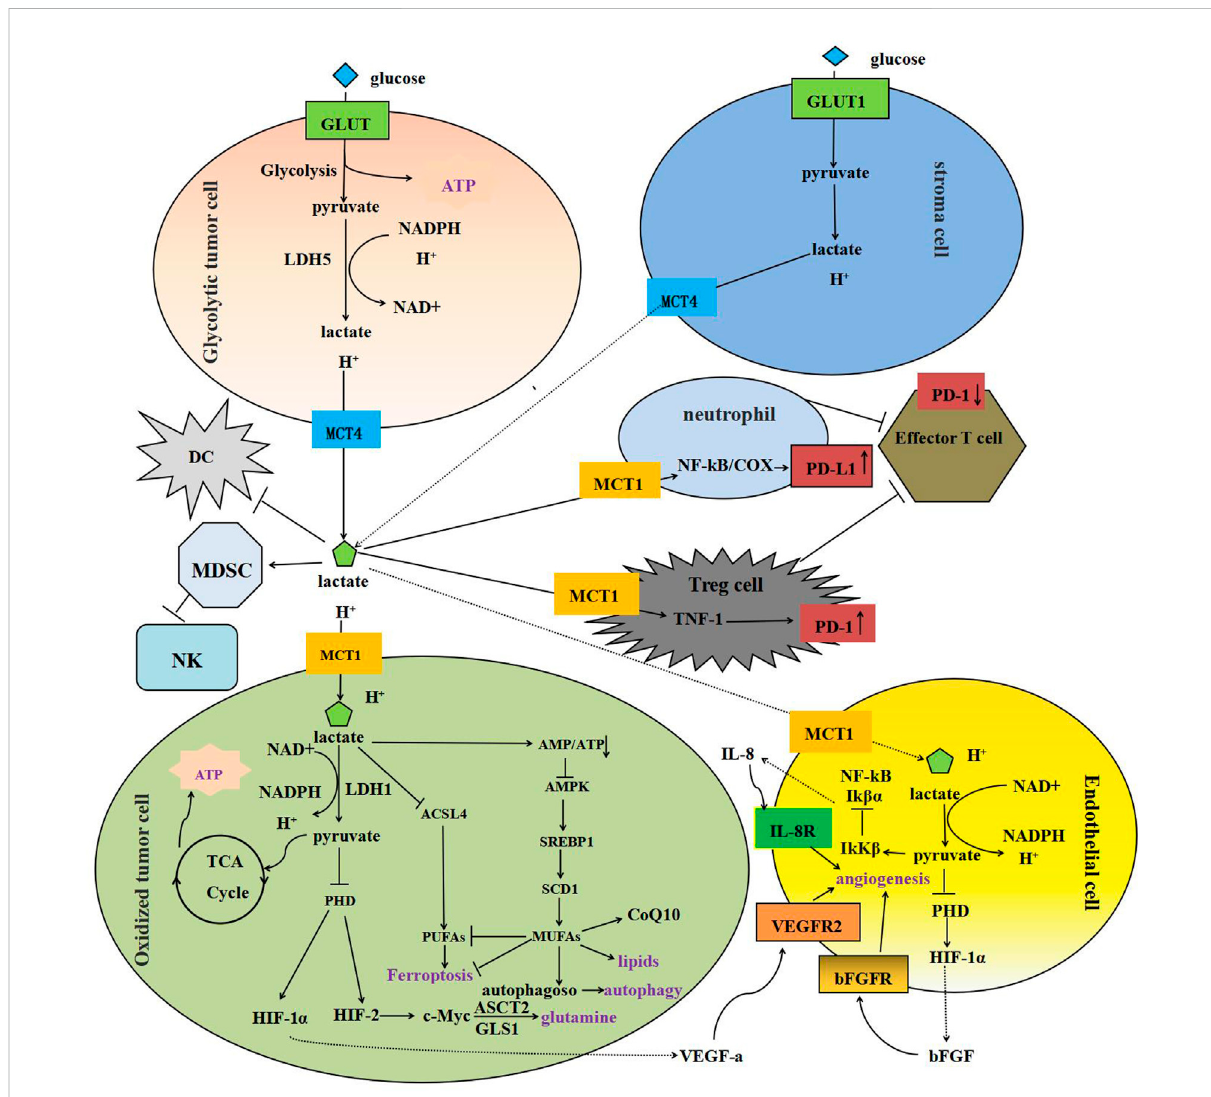
FIGURE 1 Model depicting MCT-mediated lactate transportin cancer: metaboliccrosstalk,immunosuppression, tumor angiogenesis and anti-apoptosis. (A) MCT1-4-mediated lactate shuttling between glycolytic tumor cells and oxidized tumor cells Firstly, glycolytic tumor cells and stromal cells in the hypoxic region produce lactate and hydrogen ions by glycolysis, which are excreted into the tumor microenvironment by MCT4, and then taken up byoxidizedtumor cells expressing MCT1.It isreduced to pyruvateand NANPH byLDH and enters theTCA. Inaddition, MCT1-mediated lactate intake can lead to the disruption of AMP/ATP balance and the inactivation of AMPK, and up-regulate the expression of SCD1 through the AMPK- SREBP1 pathway to promote the biosynthesis of MUFAs. MUFAs are substrates for the synthesis of various lipids. Finally, lactate ingestion via MCT1 stimulates glutamine uptake and catabolism by inhibiting PHD, stabilizing HIF-2 α , transactivating c-Myc, and upregulating ASCT2 and GLS1 expression. (B) MCT-mediatedlactatetransportinhibitsimmunecellsMCT-mediatedlactatetransportaffectsthematurationofDCSbyreducingthe ef fi ciency of NF- κ B binding to DNA, promotes the differentiation of peripheral blood mononuclear cells in MDSCs, and reduces the activity of NK cells. MCT-mediated lactate intake promotes the translocation of activated TNF-1 to the nucleus and up-regulates the expression of PD-1 in Tregs, but inhibits in effector T cells. PD-1 blockade activates PD-1-expressing Treg cells and inhibits effector T cells. In addition, lactate enters neutrophils through MCT1 and induces the expression of PD-L1 through NF- κ B/COX-2 pathway, which reduces the cytotoxicity of T cells. (C) MCT-mediated lactate transport promotes tumor angiogenesis In oxidized tumor cells and endothelial cells, lactate is taken up via MCT1 and oxidized to pyruvate, and then inhibits PHD and catalyzes the hydroxylation of HIF-1 α , which stimulates the transcription of vascular VEGF-a, VEGFR2 and bFGF. In addition, pyruvate can regulate the expression and activity of I κ K β , leading to phosphorylation and subsequent proteasome degradation of I κ B α , nuclear translocation of NF- κ B and transcription of the proangiogenic factor IL-8. VEGF-a, VEGFR2, bFGF and IL-8 are all pro-angiogenic factors with good